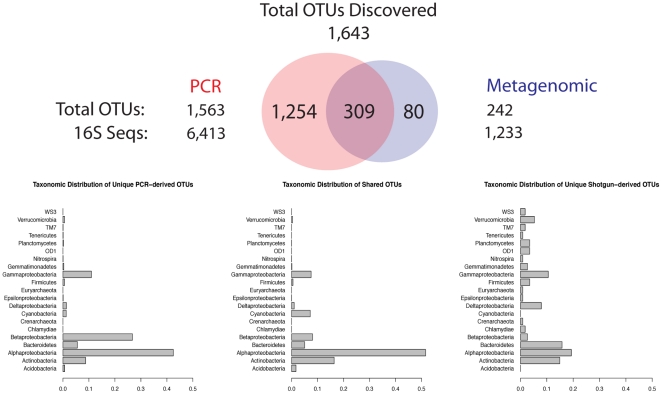
Overlap between GOS OTUs revealed by PCR sequencing and metagenomic sequencing.
PhylOTU was used to identify OTUs from a data set comprised of both PCR and shotgun SSU-rRNA sequences obtained from six Global Ocean Survey samples. The 1,254 OTUs that contained only PCR sequences at a clustering threshold of 0.03 were designated as OTUs unique to PCR, while those 80 OTUs that contained only metagenomic sequences at the corresponding clustering threshold of 0.15 (see Results) were designated as OTUs unique to metagenomic sequencing. The 309 OTUs identified by both PCR and shotgun sequencing was determined by using a clustering threshold of 0.03 (162 shared OTUs are identified when a threshold of 0.15 is used). The total number of OTUs and the total number of SSU-rRNA sequences are shown on the left and right of the Venn-Diagram for the PCR (threshold = 0.03) and metagenomic data (threshold = 0.15), respectively. The taxonomic distribution of each set of OTUs is shown beneath the Venn-Diagram. Here, every sequence from each OTU was taxonomically classified into major clades of Bacteria (approximately phylum level designations) using the Ribosomal Database Project classification software. The relative abundance of each taxonomic group is plotted along the x-axis (specific values can be found in Table S5). Clades exhibiting less than 1% relative abundance across all sets of OTUs are not shown.